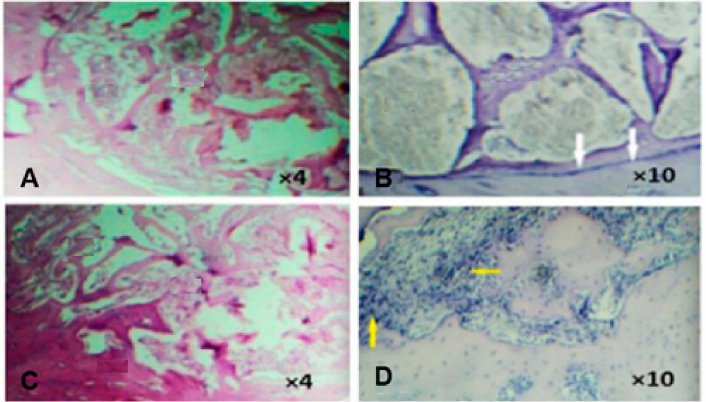
Figure 19. Optical images showing the presence of bone trabeculae units with the basal bone four weeks after surgery [( A ) at 4 × magnification and ( B ) at 10 × magnification] and two weeks after surgery [( C ) at 4 × magnification and ( D ) at 10 × magnification] [129].